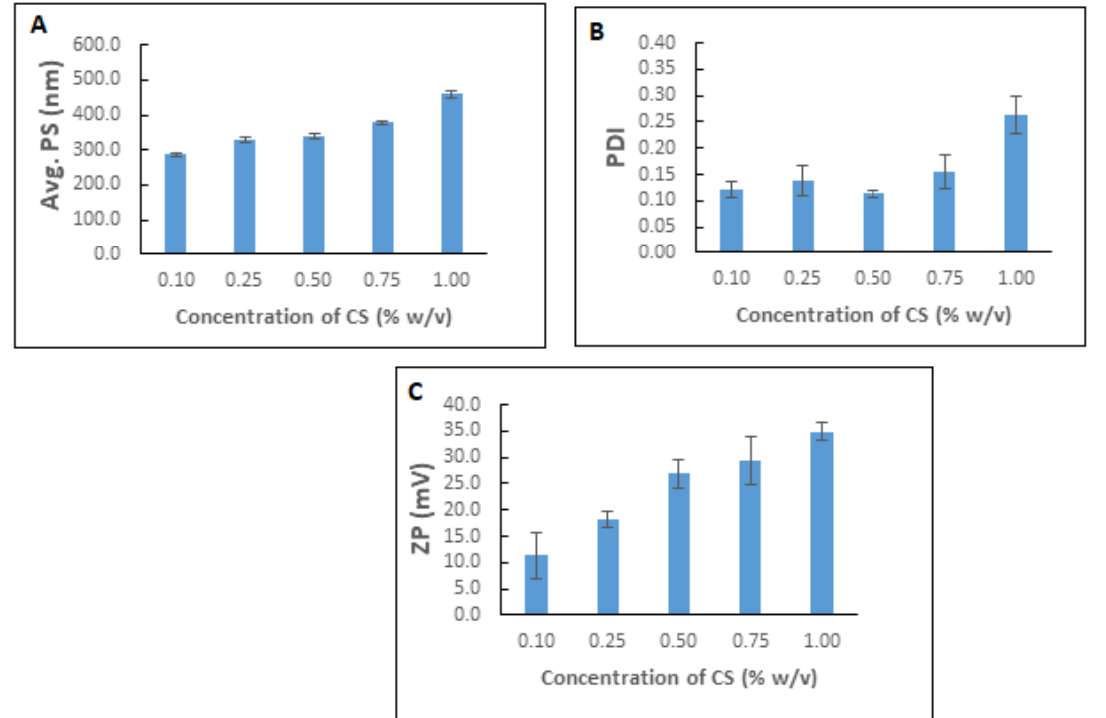
Figure 2. Effect of CS concentration on various parameters ( A ) particle size; ( B ) PDI; ( C ) ZP of CS-RES-PLGA NPs.